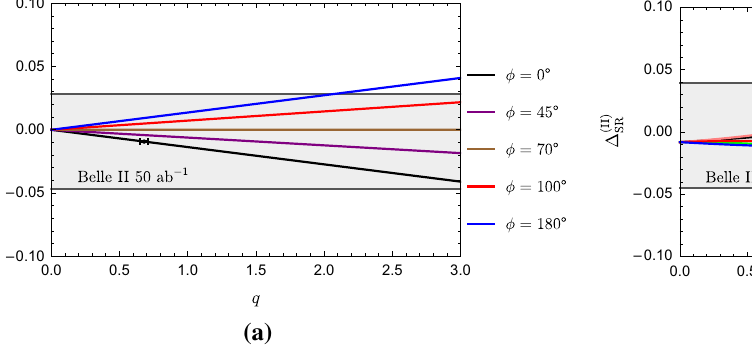
and perfect measurements of ing an uncertainty of ± 0 . 042 for A π 0 K S CP the other observables entering the sum